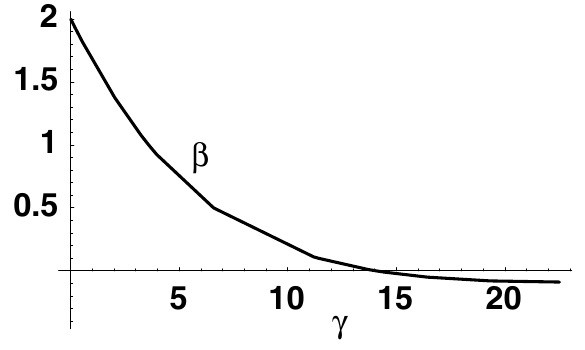
beam longitudinal axis with and without space charge.